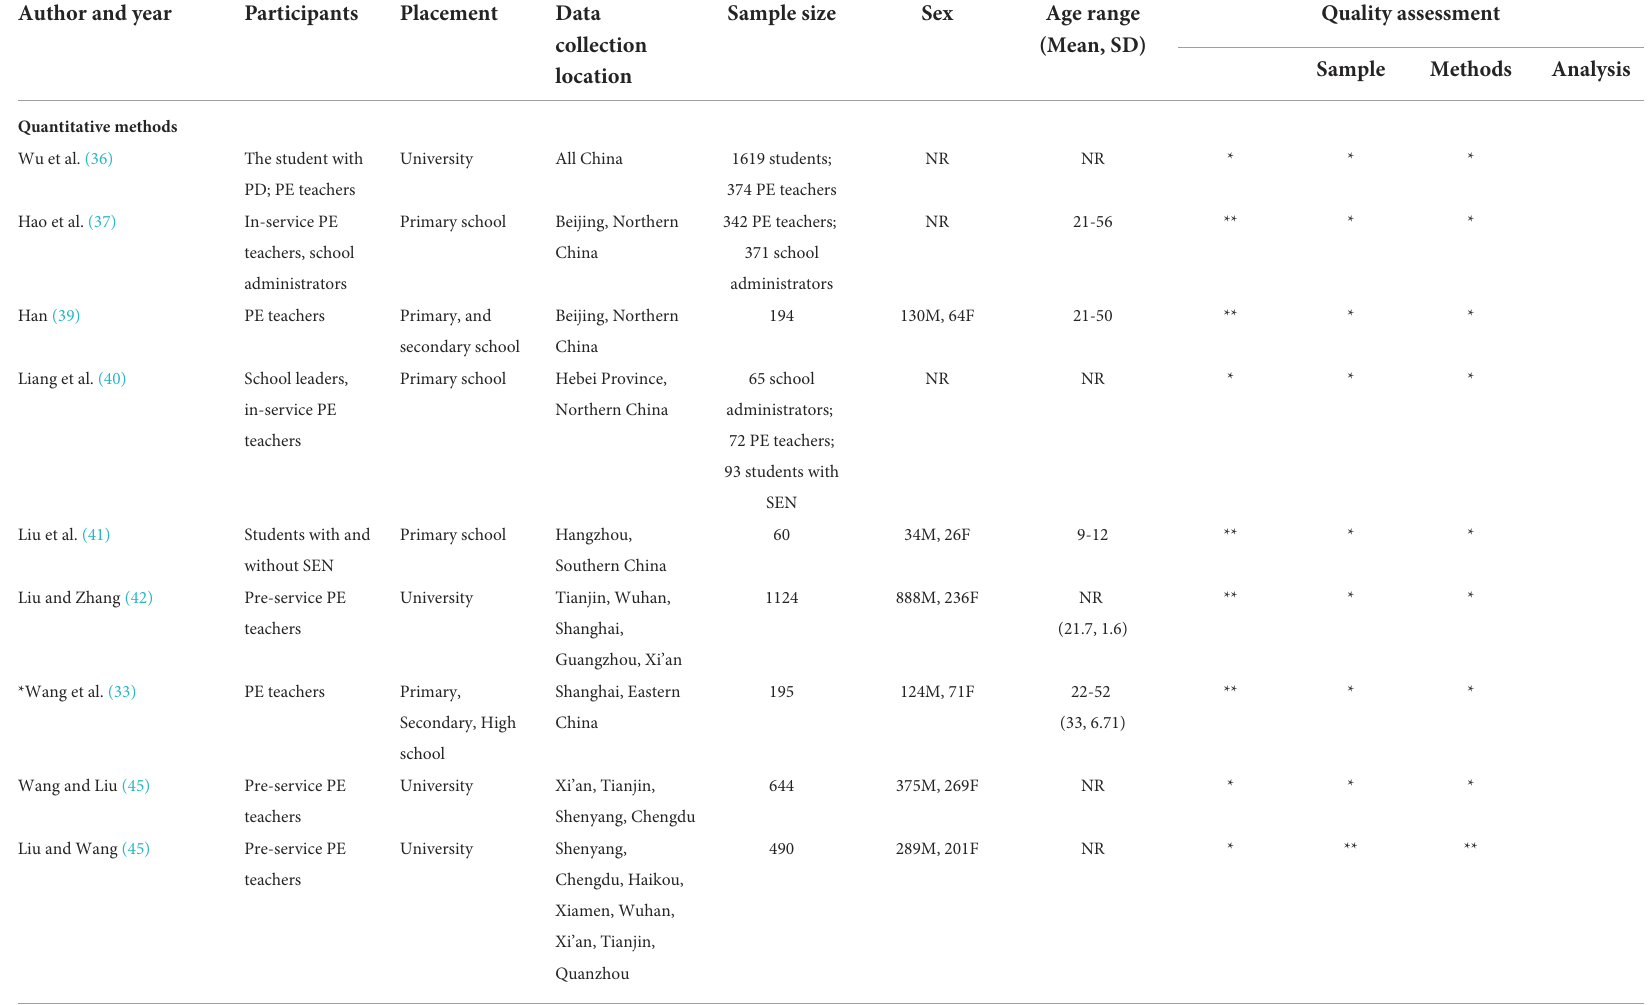
TABLE 1 Summary of participants’ characteristics and quality assessment of included